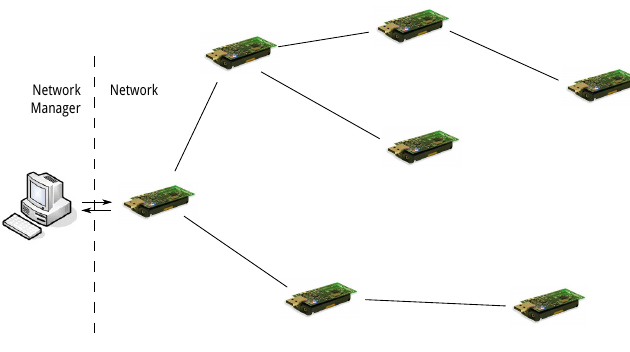
Figure 1. The network manager residing on a device capable of higher level processing power either on or connected to the root of the